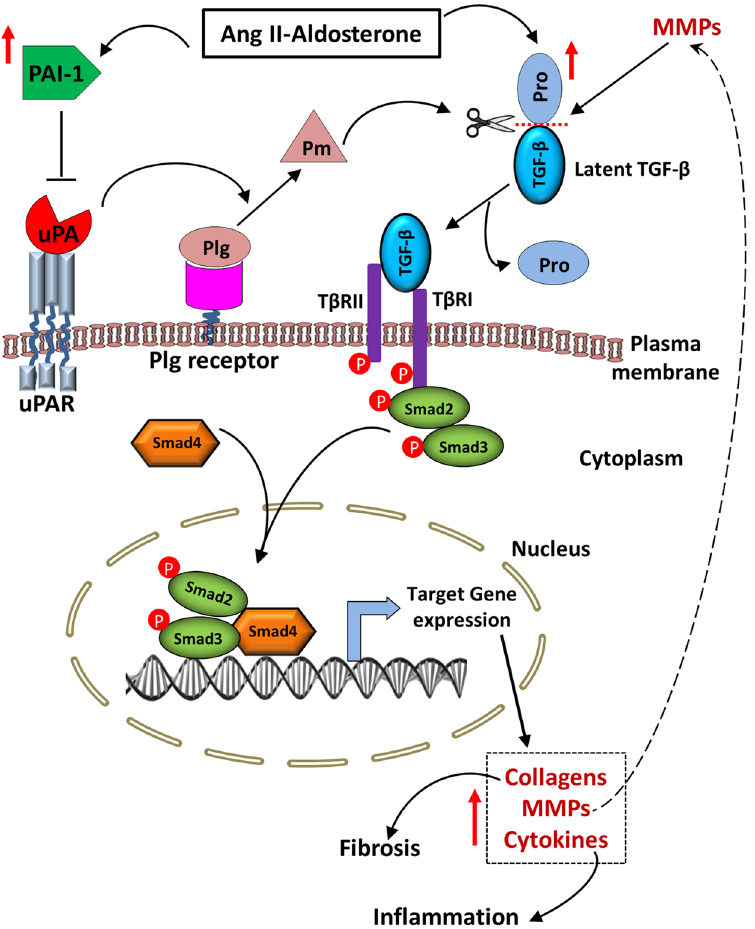
Figure 7. Schematic diagram showing functional roles of PAI-1 and uPA during AngII-Ald-induced cardiac fibrosis. AngII-Ald infusion in mice induces the expression of PAI-1 and TGF- β in the heart. Inhibition of TGF- β activation by PAI-1 inhibiting tPA/uPA generation of Pm suppresses TGF- β signaling in hearts. Binding of active TGF- β to its receptors (TGF β R) facilitates the recruitment of Smad2/3 to TGF β R leading to the phosphorylation of Smad2/3. Phosphorylated Smad2/3 forms a complex with Smad4 and translocates to the nucleus where it regulates transcription of target genes involved in cardiac tissue remodeling and fibrosis. Increased MMP activity in hearts further enhances the activation of TGF- β